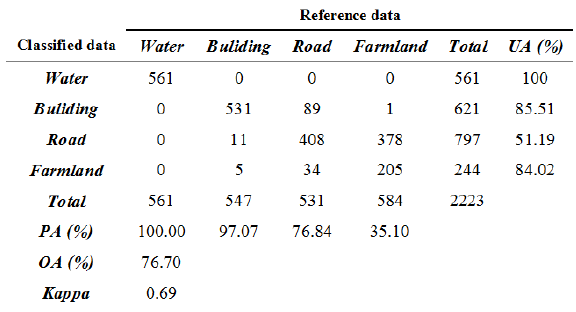
Table 3. Classification Accuracy of the Wishart